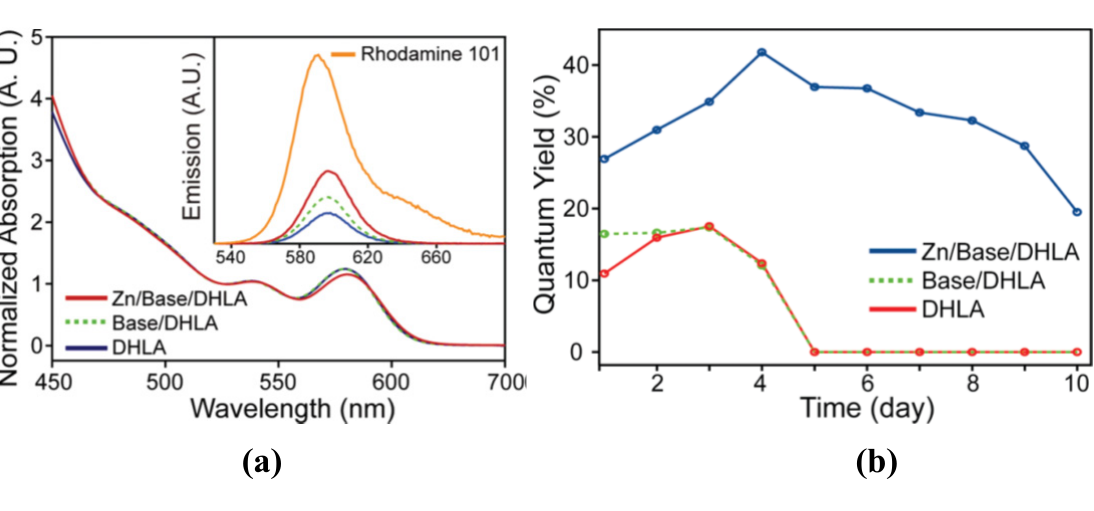
Figure 5. (a) Normalized absorption spectra of water-soluble CdSe/ZnS using different cap exchange methods. Inset: Emission spectra of same QDs and Rhodamine 101, excited at 525 nm. (b) Quantum yield of water-soluble CdSe/ZnS using different cap exchange methods over time. Zero quantum yield indicates the precipitation of the samples